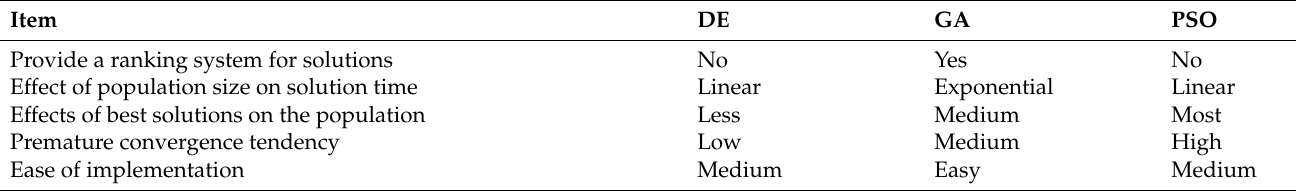
Table 16. Analysis of the qualitative differences between DE, GA, and